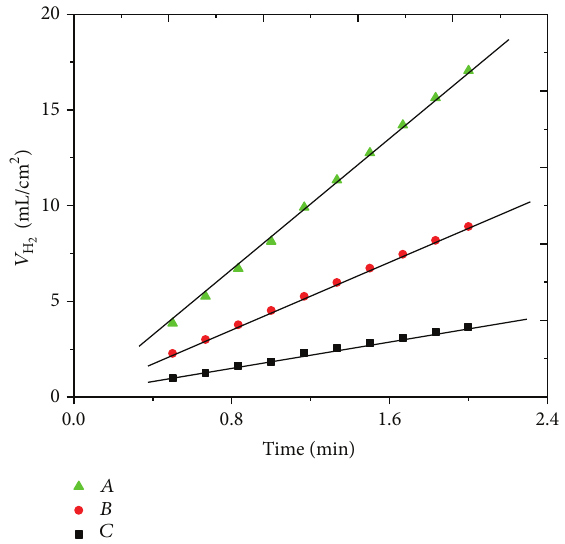
Figure 5: Influence of pectates as inhibitor of corrosion of Al in alkaline media. [OH − ] = 4.0 and I = 4.0 moldm −3 at 35 ∘ C. 𝐴 : absence of inhibitor; 𝐵 : 0.03 moldm −3 inhibitor; 𝐶 : 0.06 moldm −3